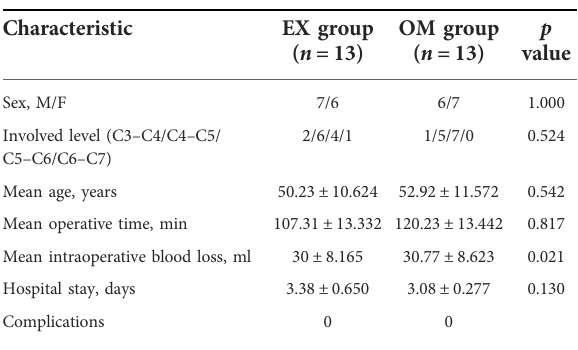
TABLE 2 Comparison between the OM and EX groups. Clinical evaluation